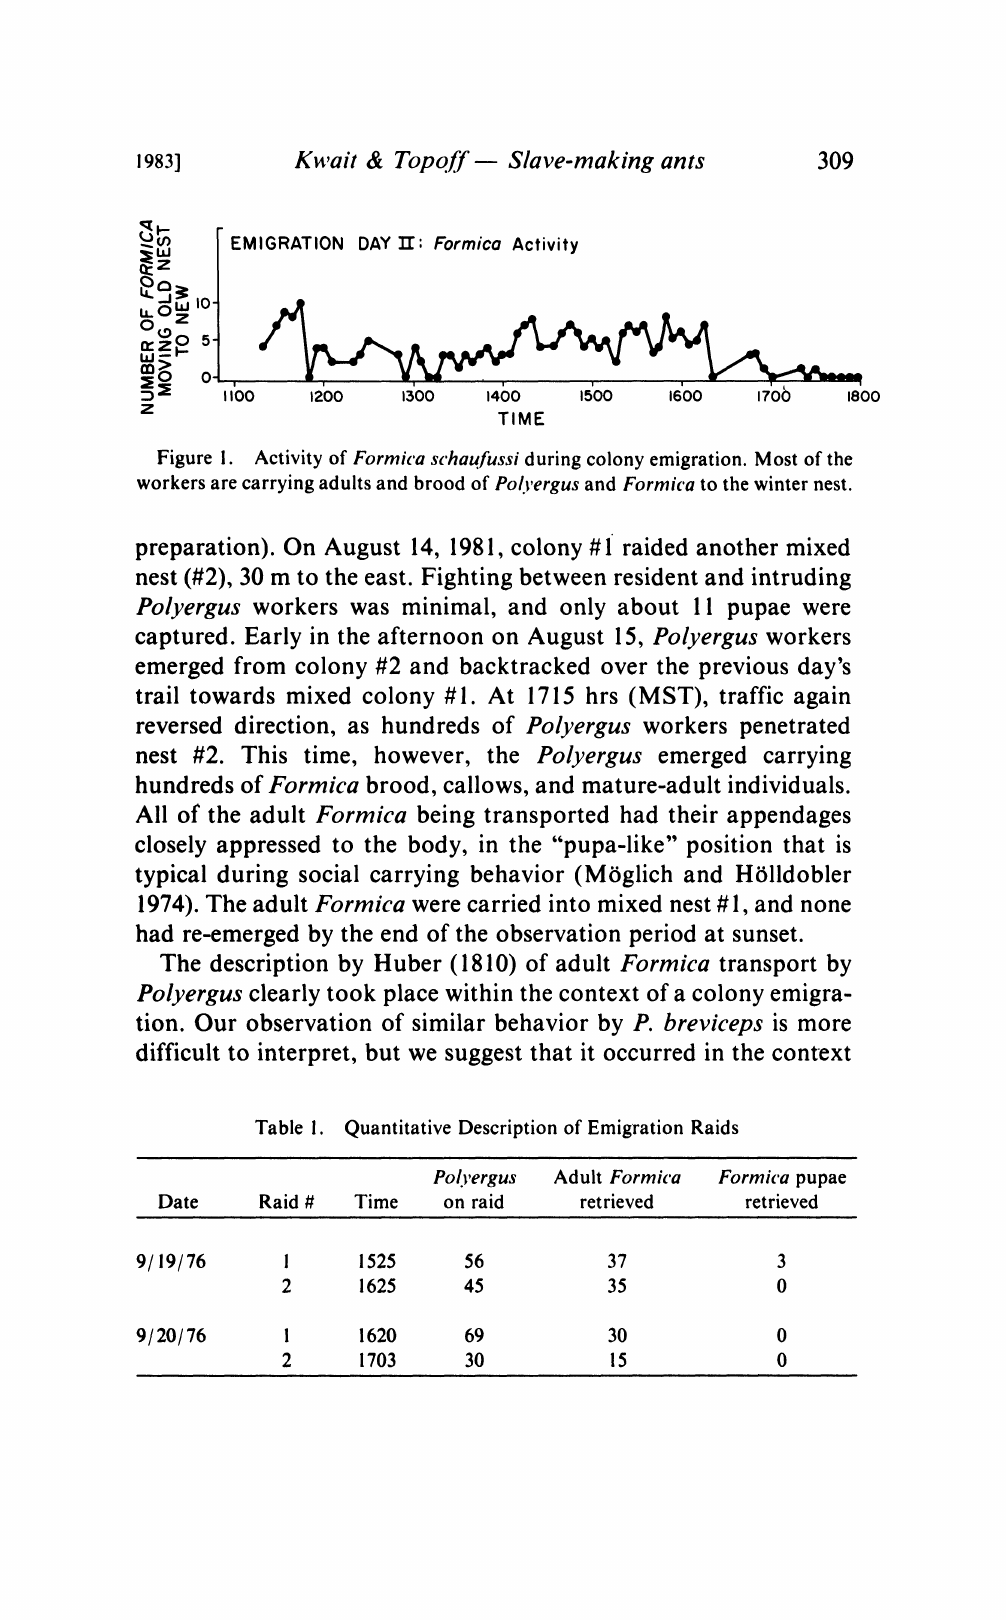
Table 1. Quantitative Description of Emigration